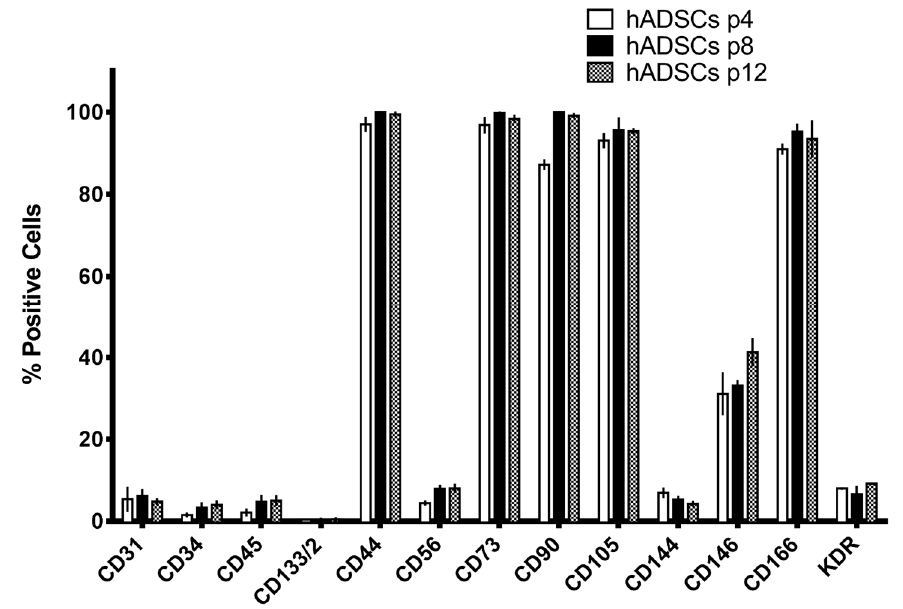
Figure 3. Fluorescence-Activated Cell Sorting (FACs) analysis of hADSCs isolated from activated lipoaspirates. Cell surface phenotype of hADSCs derived from lipoaspirated adipose tissue activated with the application of an orbital shaking force (97× g ) for 10 min. Cell surface phenotype was investigated by FACS (see Materials and Methods for details) on hADSCs maintained in α MEM at three different passages in culture (passage 2, white bars; passage 8, black bars; passage 12, grey bars). The assay was performed in three different cases, and each case at each passage was investigated in triplicate. Mean ± SEM of the three different cases are reported in the graphs.